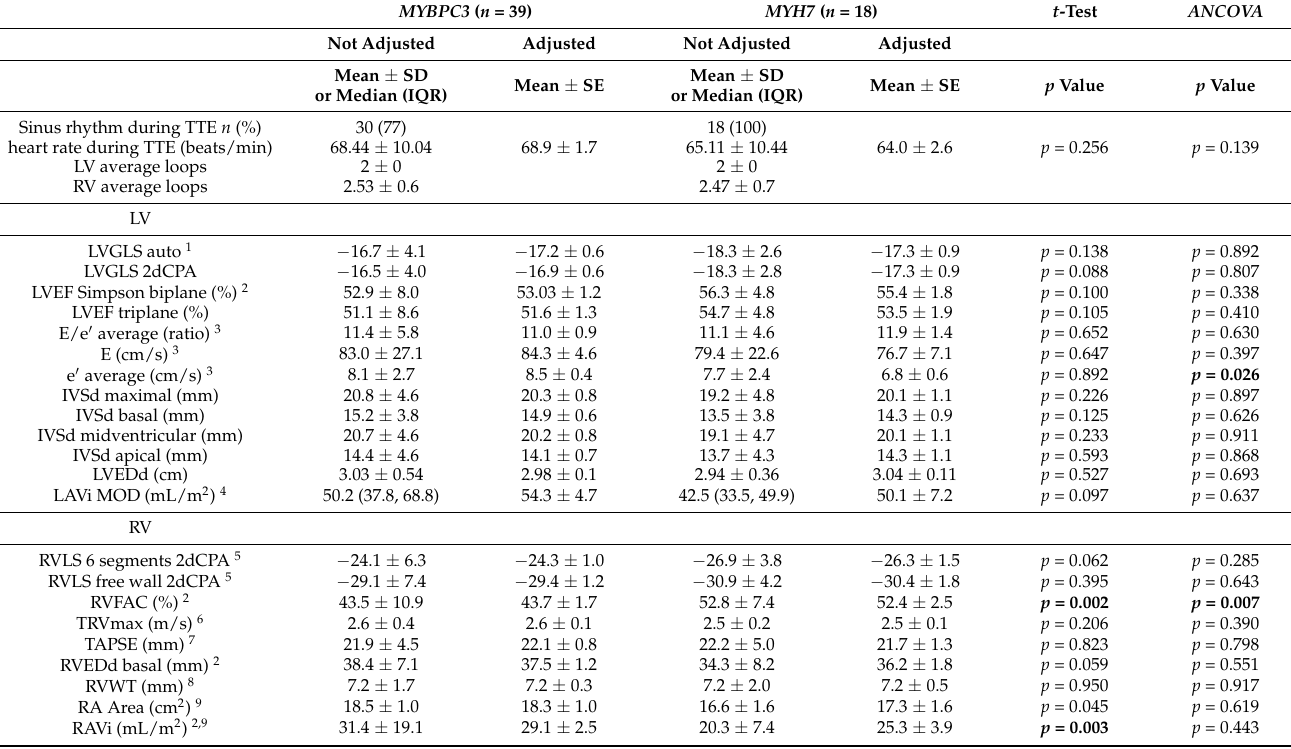
Figure 3. Echocardiographic analysis of the right ventricle. Estimated marginal means and standard error adjusted for age, sex and septum reduction therapy and compared between MYBPC3 (dark green) and MYH7 (light green) mutation carriers. ( a ) Right ventricular strain analysis (RV4CLS) ( p = 0.285) and strain analysis of the right free wall (RVFWLS) ( p = 0.643); ( b ) right ventricular fractional area change (RVFAC) ( p = 0.007), tricuspid annular plane systolic excursion (TAPSE) ( p = 0.798); ( c ) enddiastolic basal diameter of the right ventricle (RVd) ( p = 0.551) and enddiastolic thickness of the right ventricular free wall (RVWT) ( p = 0.917). Table 3. Echocardiographic parameters compared between MYBPC3 and MYH7 mutation